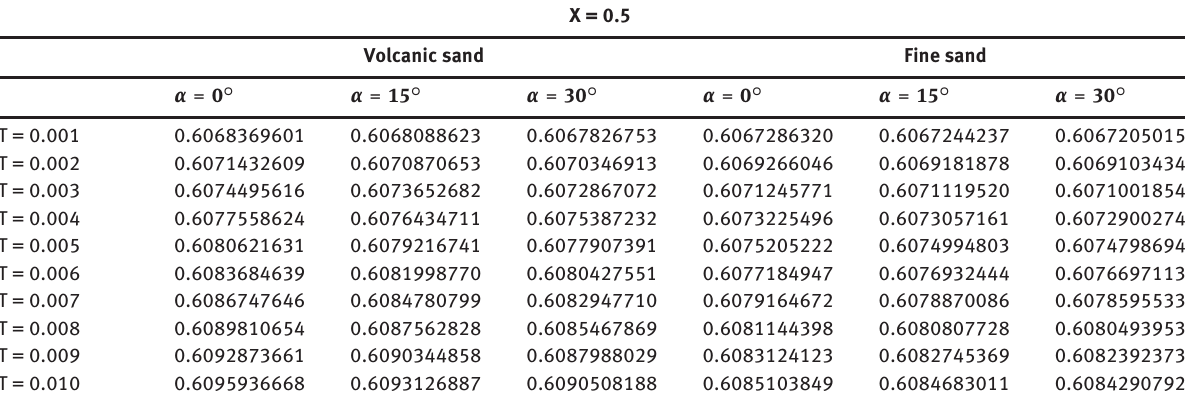
Table 2: Saturation of water in Volcanic Sand and in Fine sand for Heterogeneous inclined Porous Media